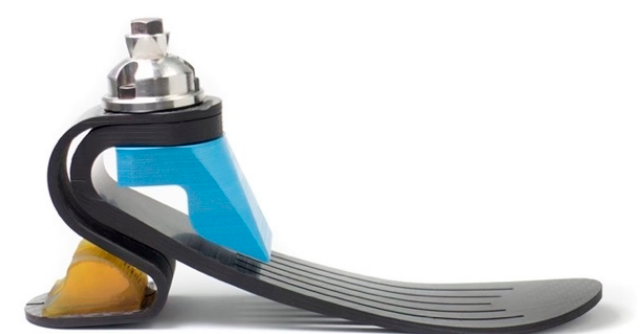
Figure 1. The sPace prosthetic